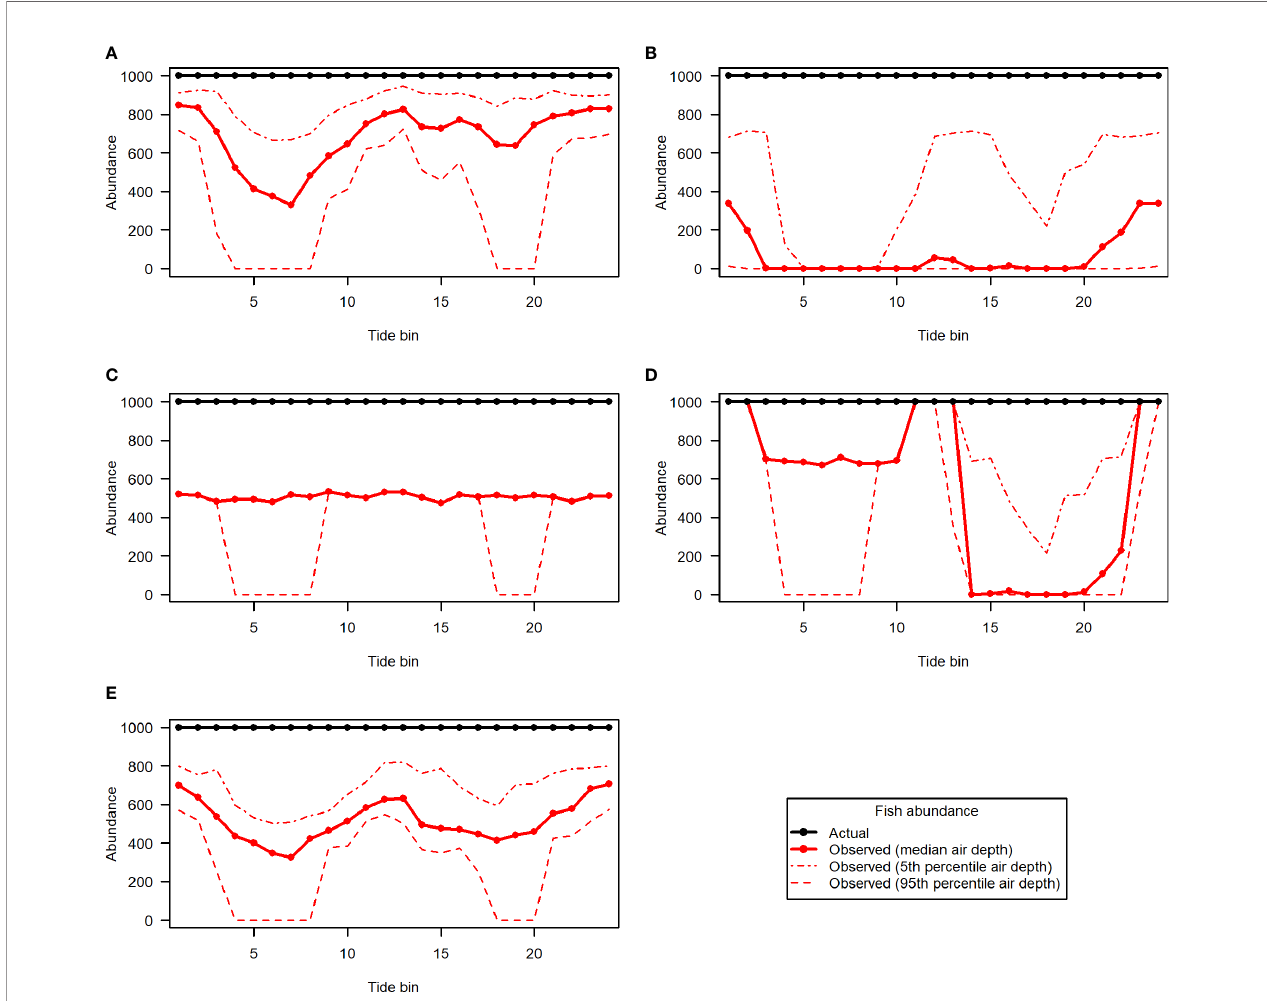
FIGURE 11 | Fish abundance over the course of the tidal cycle for simulated fi sh distribution scenarios 1 to 5 [ (A – E) , respectively]. Actual abundance (black) is shown in contrast to abundance that would be observed under different levels of entrained air contamination (red